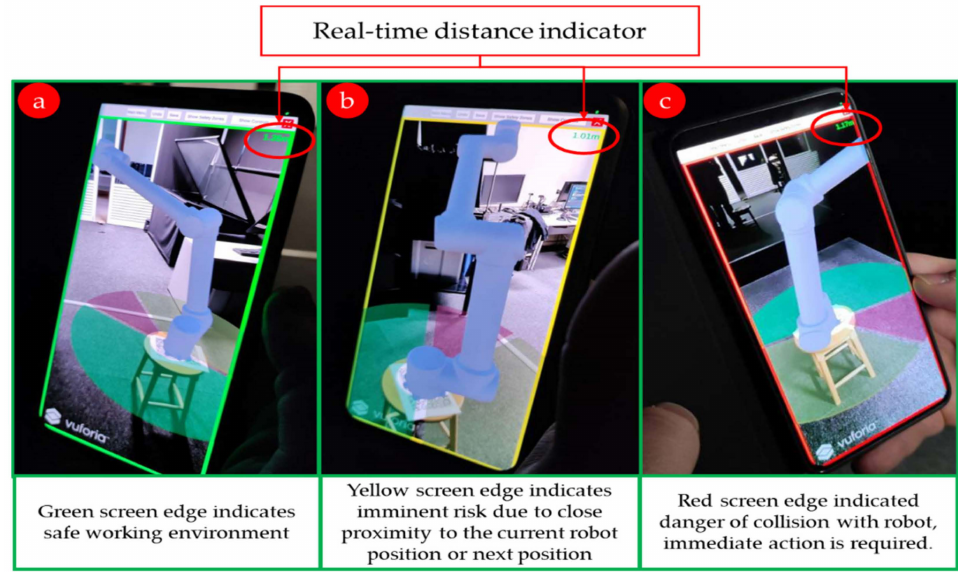
Figure 4. AR visualization of the virtual robot, the safety zones, and the distance